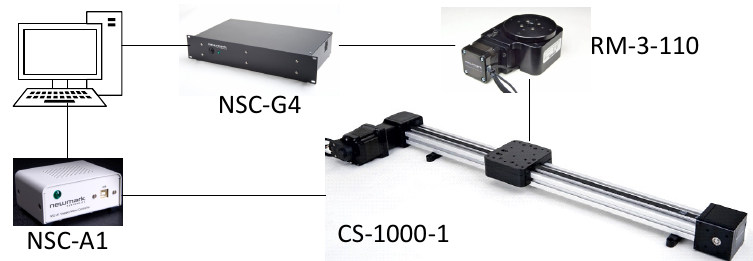
Figure 3. The testing platform setup.